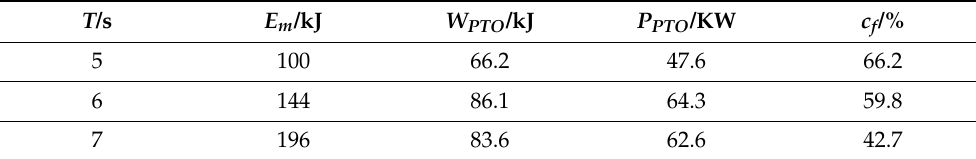
Figure 6. Different wave period power curves. Table 1. Wave energy conversion efficiency.